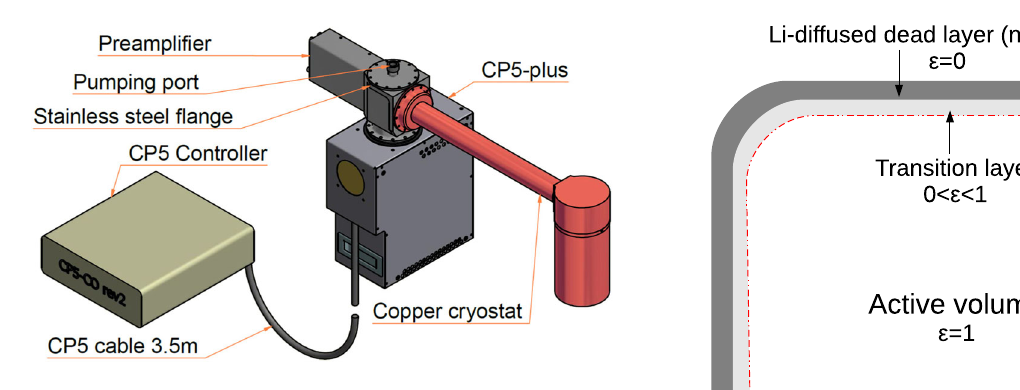
Fig. 2 Overall Conus detector design. The HPGe diode is included in the cylindrical copper end cap